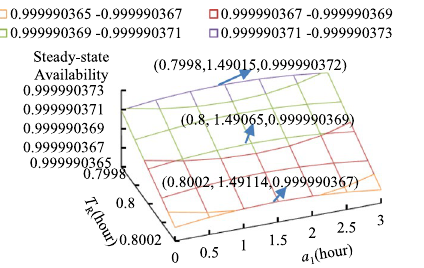
Fig. 7 Steady-state availability under different trigger intervals of software rejuvenation technique and system repair time